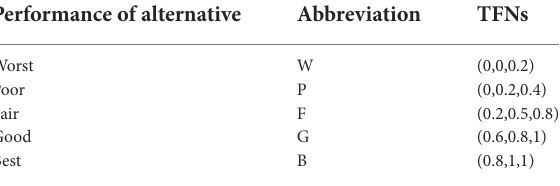
TABLE 1 Linguistic variable for the evaluation of alternatives (component A of Z-number).